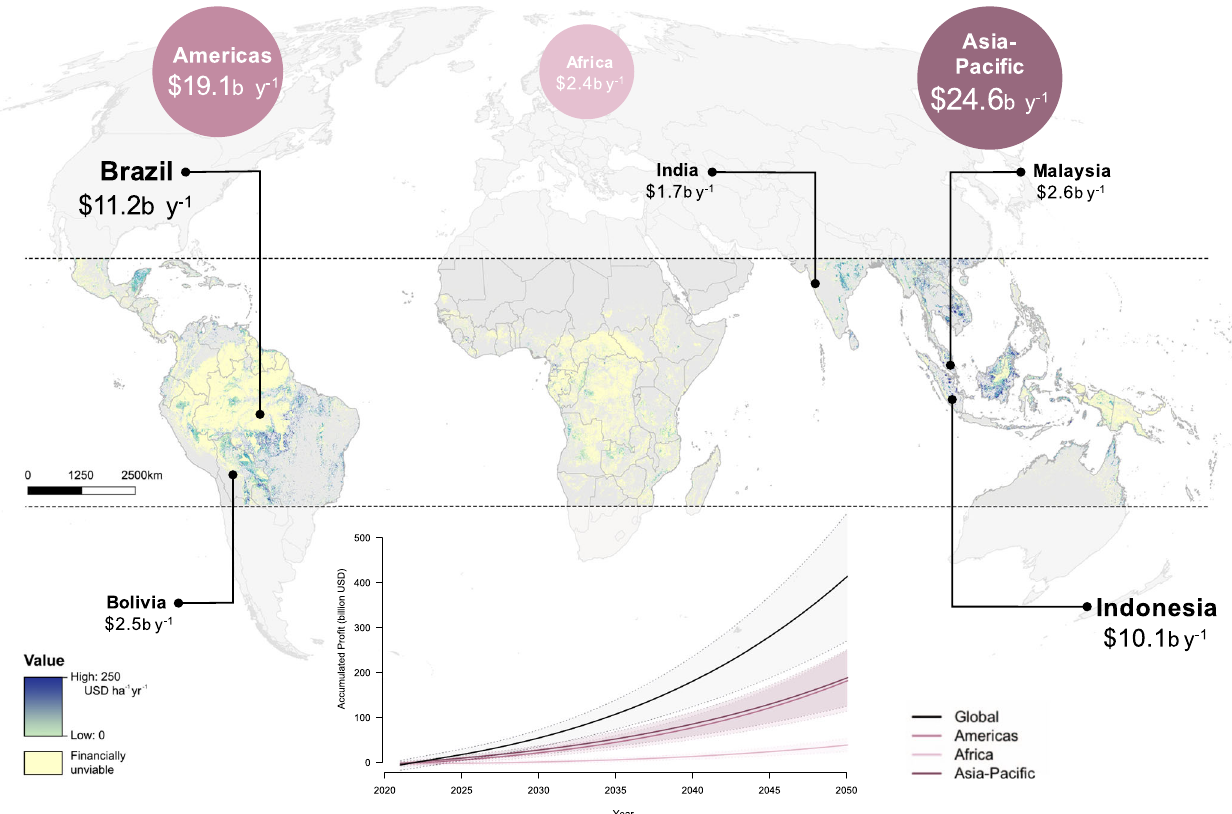
Fig. 2 Global forest carbon return-on-investment from fi nancially viable sites. Estimates are presented as net present values over a 30-year timeframe, highlighting the corresponding estimates across each region and fi ve countries with the highest potential. We also present the accumulation of pro fi ts overtime at the global and regional levels, with shadings around the lines representing standard deviation (inset).